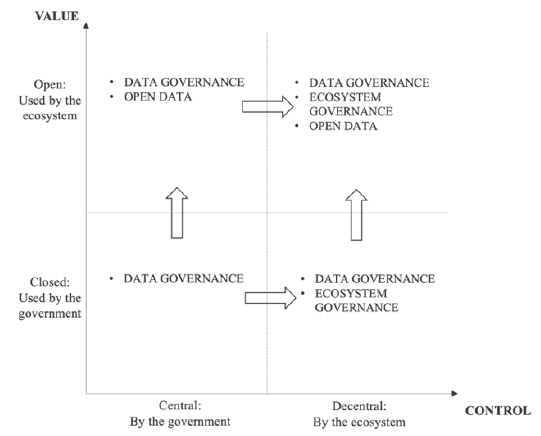
Figure 5. Urban Digital Twin challenge